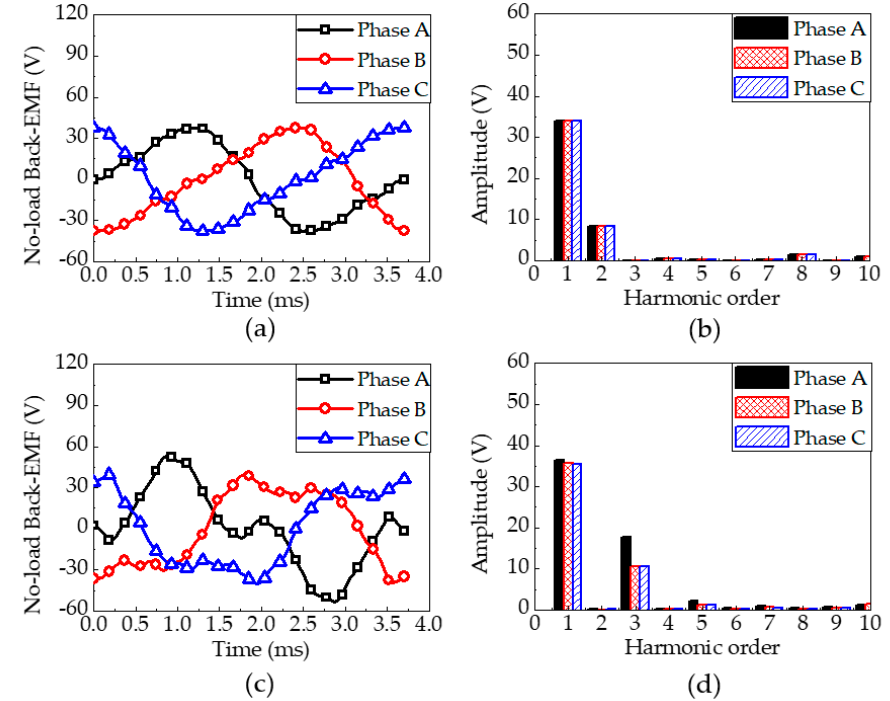
Figure 6. Characteristics of no-load back-EMF of 270 Hz in the inner winding: ( a ) Waveforms when the output rotor and the outer winding operate at 1246 rpm and 0 Hz, respectively; ( b ) Time harmonic spectra of Figure 6a; ( c ) Waveforms when the output rotor and the outer winding operate at 1662 rpm and 90 Hz, respectively; ( d ) Time harmonic spectra of Figure 6c.